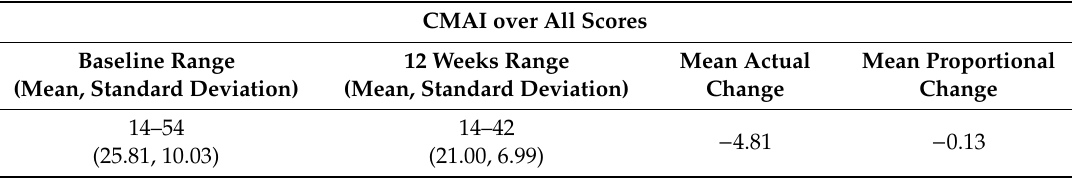
Table 7. CMAI scores from baseline to 12 weeks intervention for 32